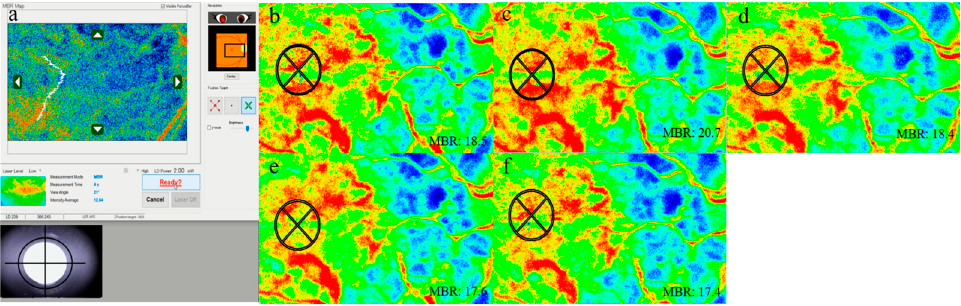
Figure 1. Laser speckle flowgraphy (LSFG) measurement screen ( a ) and the composite color map image of mean blur rate (MBR) at baseline ( b ), immediately after the test ( c ), and at 10 ( d ), 20 ( e ), and 30 ( f ) minutes later in a participant.